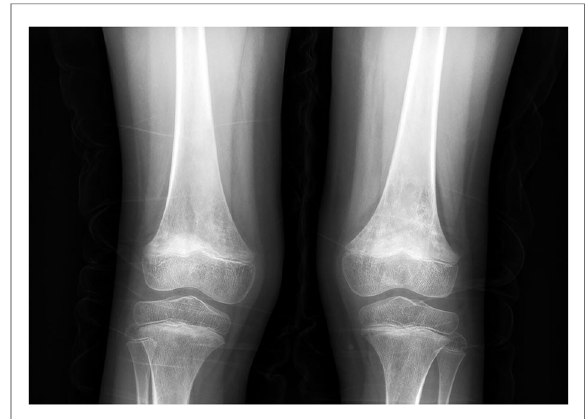
FIGURE 1 X-ray of both knee joints indicated uneven bone density in bilateral femoral diaphysis, epiphysis, and proximal tibia, with multiple low- density sites and calci fi